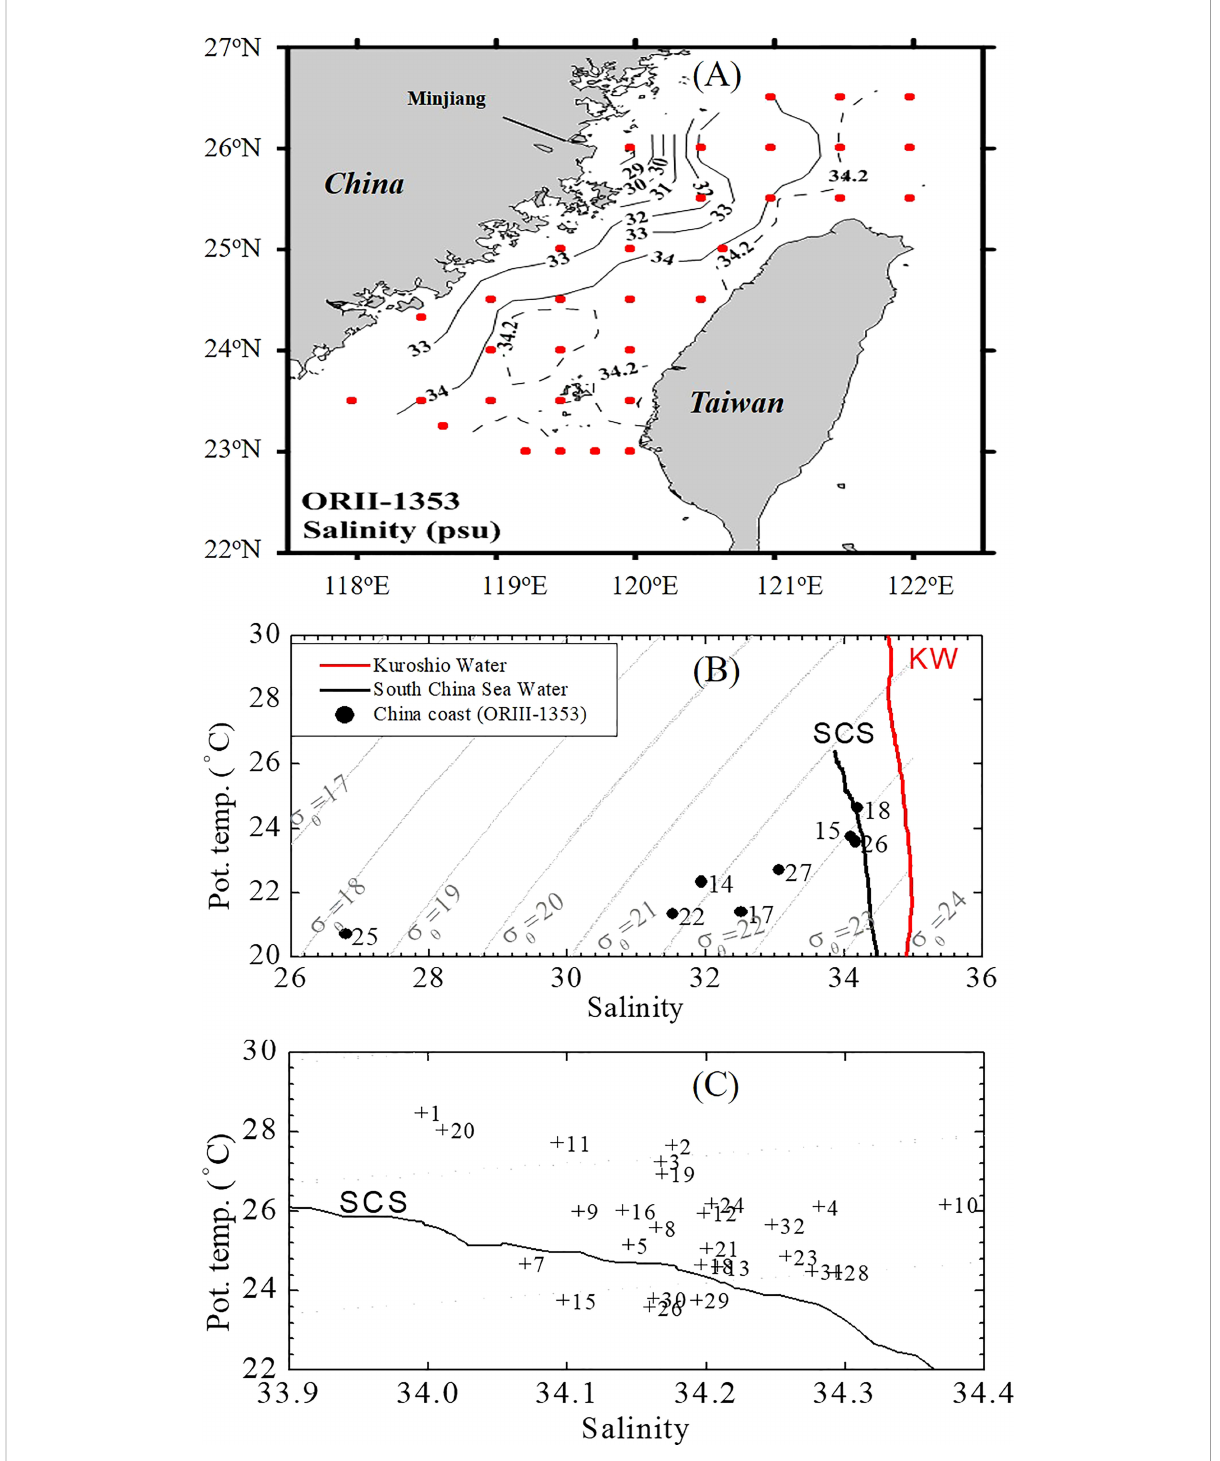
FIGURE 2 Spatial distribution of salinity in surface waters of the TS in early summer ( A ; Cruise CR1353) and plots of the temperature − salinity (T − S) relationship at sampling stations located in the western TS (on the coast of China, B ) and the central and eastern TS (on the coast of Taiwan, C ) in early summer (CR1353). The “ KW ” and “ SCS ” curves represent the typical T − S features of the Kuroshio Water (KW) and SCS Water (SCSW), respectively. The KW and SCSW represent typical waters collected from the western Philippine Sea and SCS central basin,